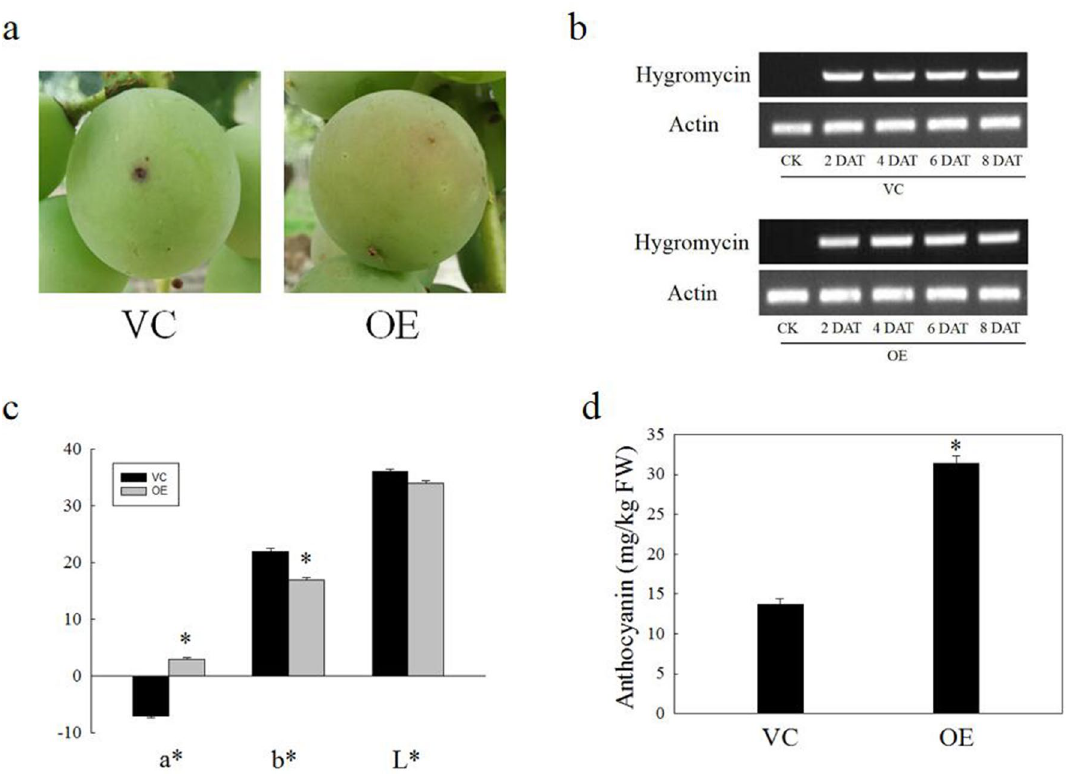
Figure 7. Transient expression result of ‘Kyoho’ berries. ( a ) ‘Kyoho’ fruits agroinfiltrated with VC (vector control) and OE (overexpression) at 6 days after injection. ( b ) Hygromycin gene (resistance marker gene) of pHB vector in fruits screened by RT-PCR. ( c ) Color parameters (L*, a*, b*) of VC and OE berries. ( d ) The total anthocyanin content of VC and OE berries. RT-PCR were normalized to the expression of VlActin